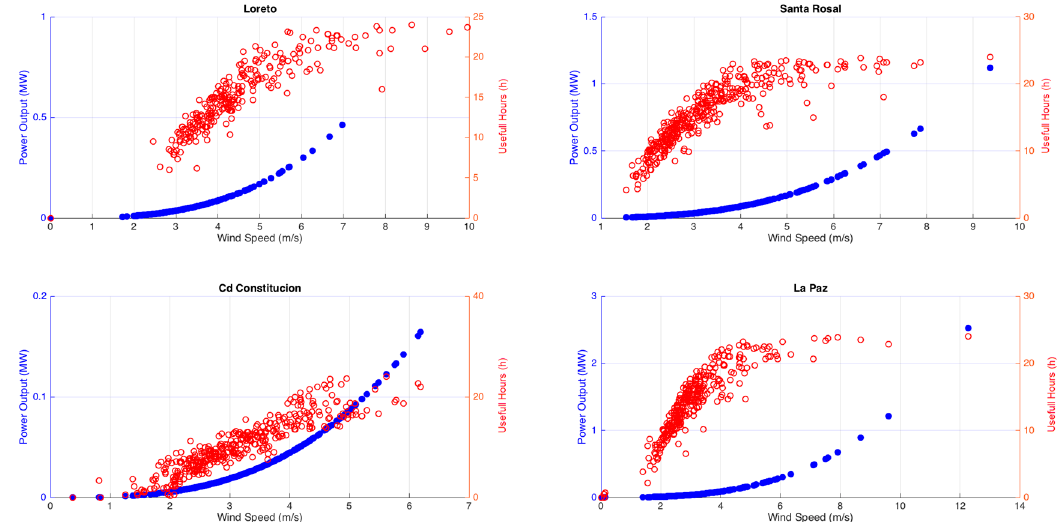
Figure 19. Power output, useful hours and wind speed by SAMs Baja California Sur.